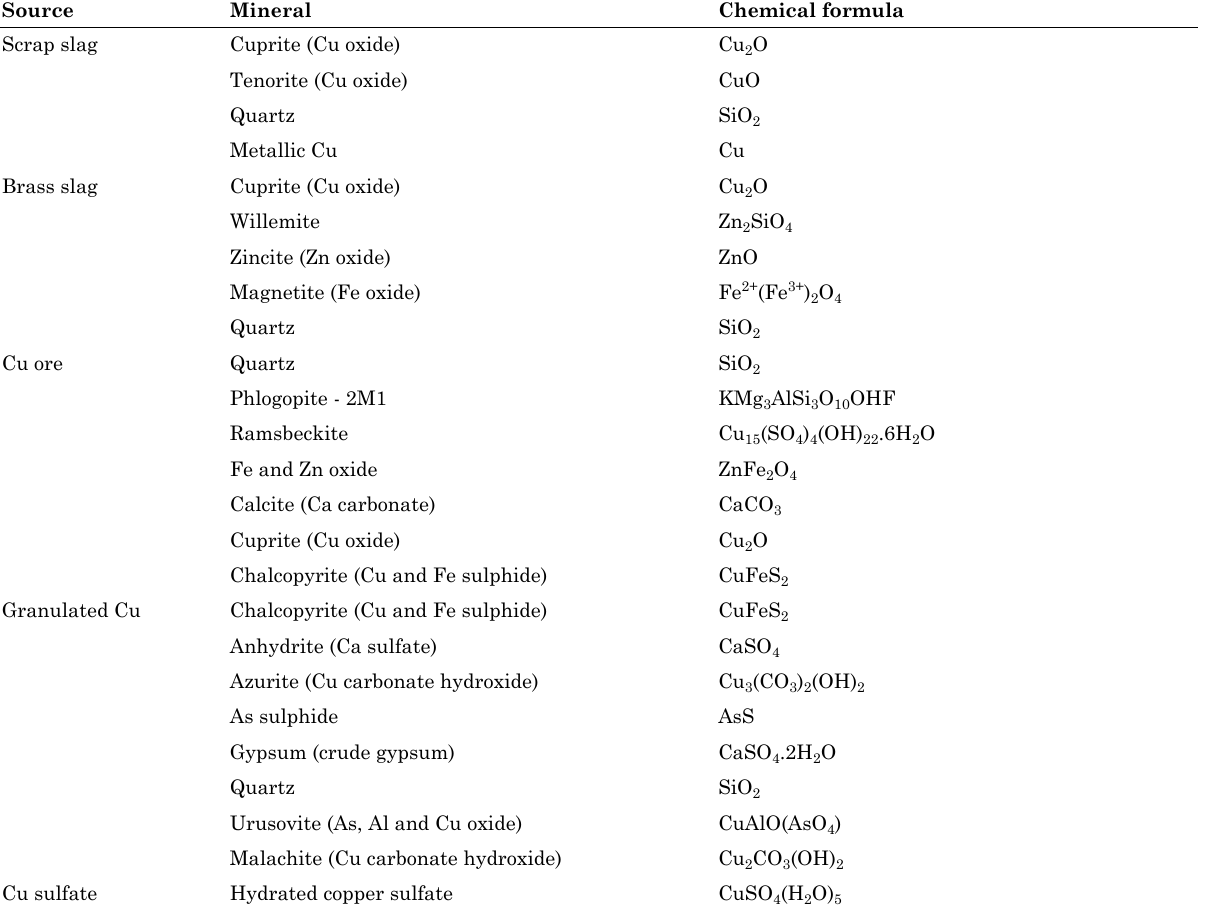
Table 3. Mineralogical composition of copper sources by X-ray diffraction